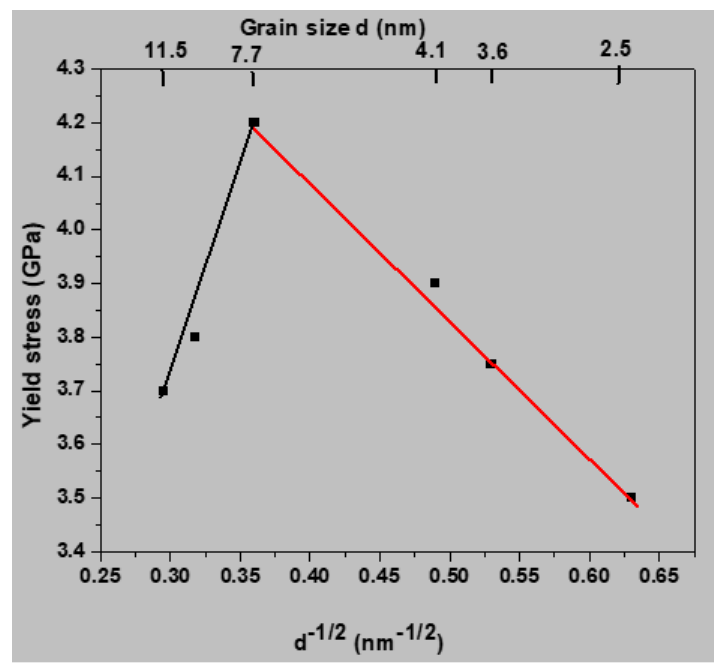
Figure 3. Influence of grain size on the yield stress at 300 K. The data were fitted by two straight lines.